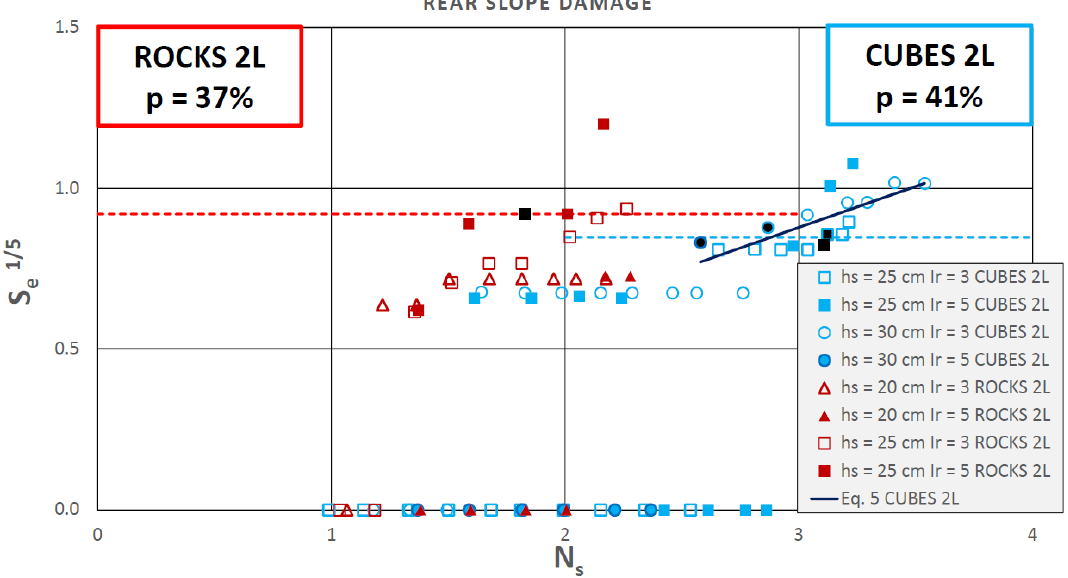
Table 4. Ranges of validation for Equation (5).